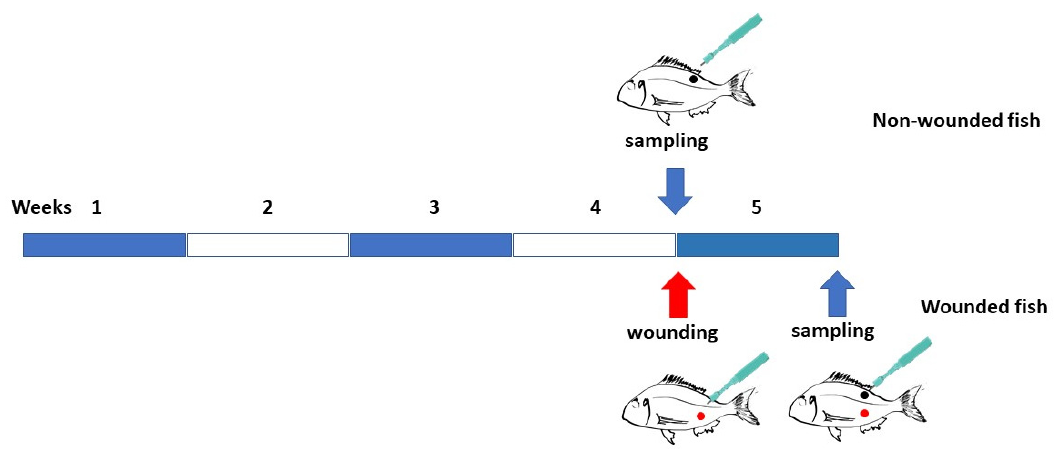
Figure 1. Experimental design. Gilthead seabream were fed for 30 days with a control diet or enriched with SpPdp11 10 9 cfu per g of diet. At 30 days of assay, after sedation, 8 fish per diet (non ‐ wounded) were sampled by taking skin samples from the middle of the left flank above the lateral line (with an 8 mm diameter biopsy punch and 2 mm deep) obtaining samples from groups C and P. The rest of fish on the left flank, similar wounds were made with the same biopsy punch but below the lateral line and fish were fed for an extra week with assigned diet. After 7 days, 8 fish per diet were anesthetized and skin samples were taken from the same location described and with the same procedure as described in the non ‐ wounded fish (groups CW and PW).